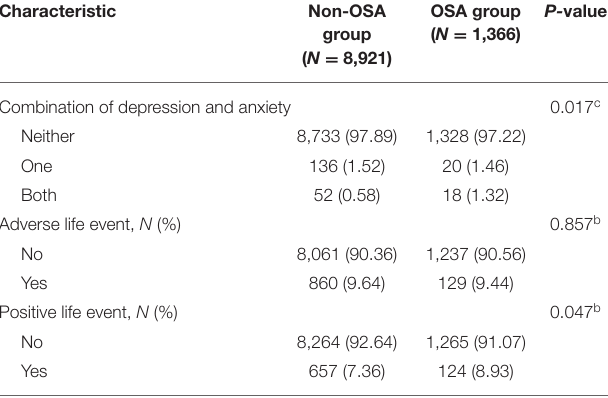
TABLE 1 | Baseline characteristics of the participants by OSA.